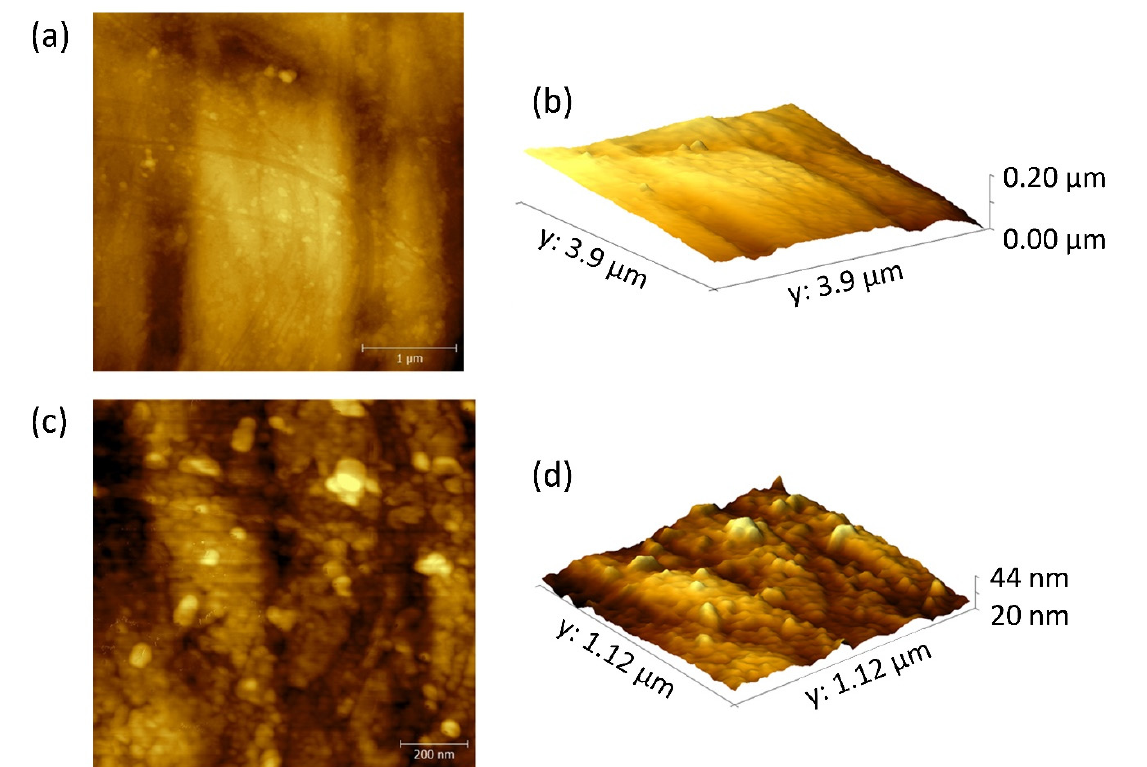
Figure 3. AFM topography images of a gold-coated NZSP pellet are shown in both two- and three- dimensional views. The scanning area of the image ( a ) and its corresponding 3D image ( b ) are ~4 µm × ~4 µm. Zoomed-in images ( c , d ) correspond to a scanning area of about 1 µm × 1 µm.